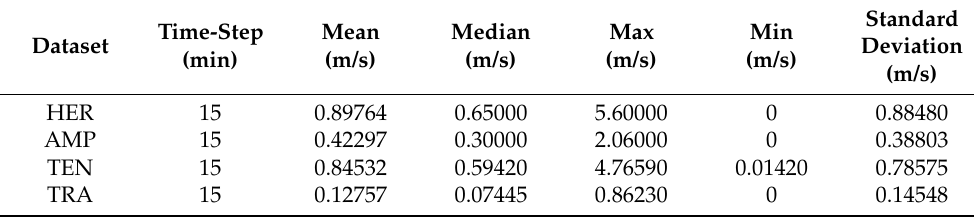
Table 1. The statistical information of wind speed